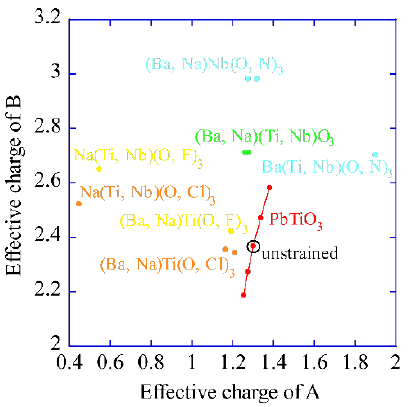
Figure 8. Histogram of the effective charges of A and B of cluster model (Ba, Na)(Ti, Nb)O 3 replaced with Cl, F, N, respectively. The values in Table 8 were used. The values of PT in Table 5 and (Ba, Na)(Ti, Nb)O 3 in Table 7 were also used for comparison.